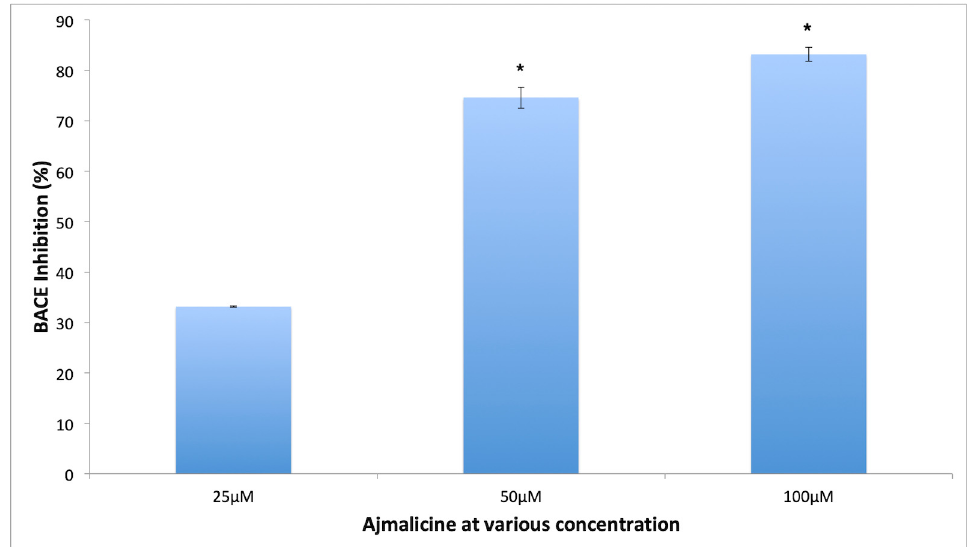
Figure 12. Concentration dependent β -site amyloid cleaving enzyme (BACE-1) inhibitory activity of AJM; values represent mean ± SEM, n = 3; and * difference in mean is statistically very significant p < 0.001 as compared to control group.